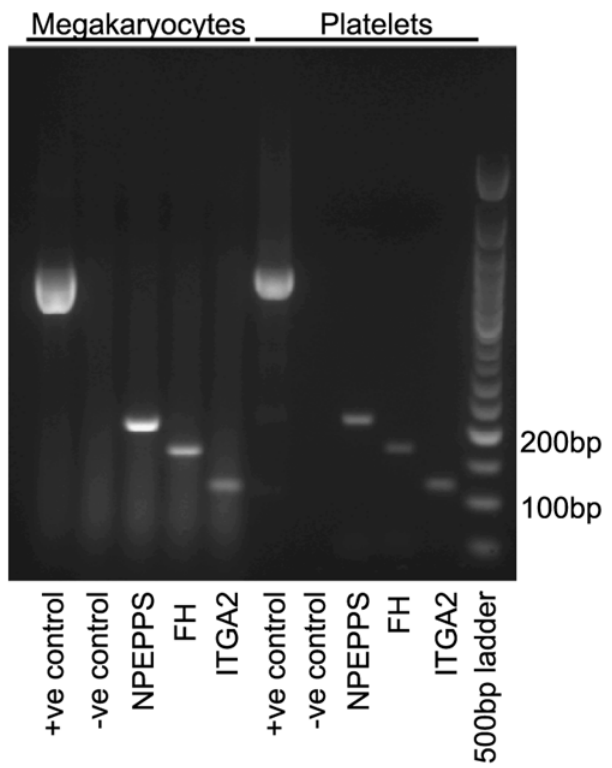
Figure 6. Agarose gel electrophoresis of PCR products. Lanes 1– 5 show products amplified from megakaryocyte cDNA; samples in lanes 6–10 contained template from platelets. Molecular size markers are in lane